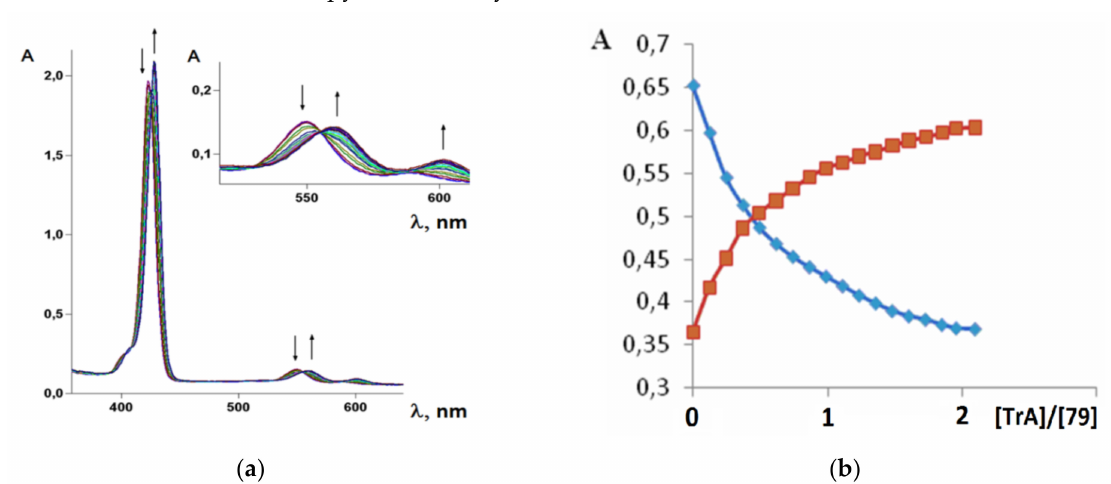
Figure 18. Changes in the absorption spectra ( a ) and titration curves ( b ) of porphyrinate 79 and TrA in toluene, 20 ◦ C. [109] = 2.7 × 10 − 5 M, [TrA] = 0 ÷ 6 × 10 − 5